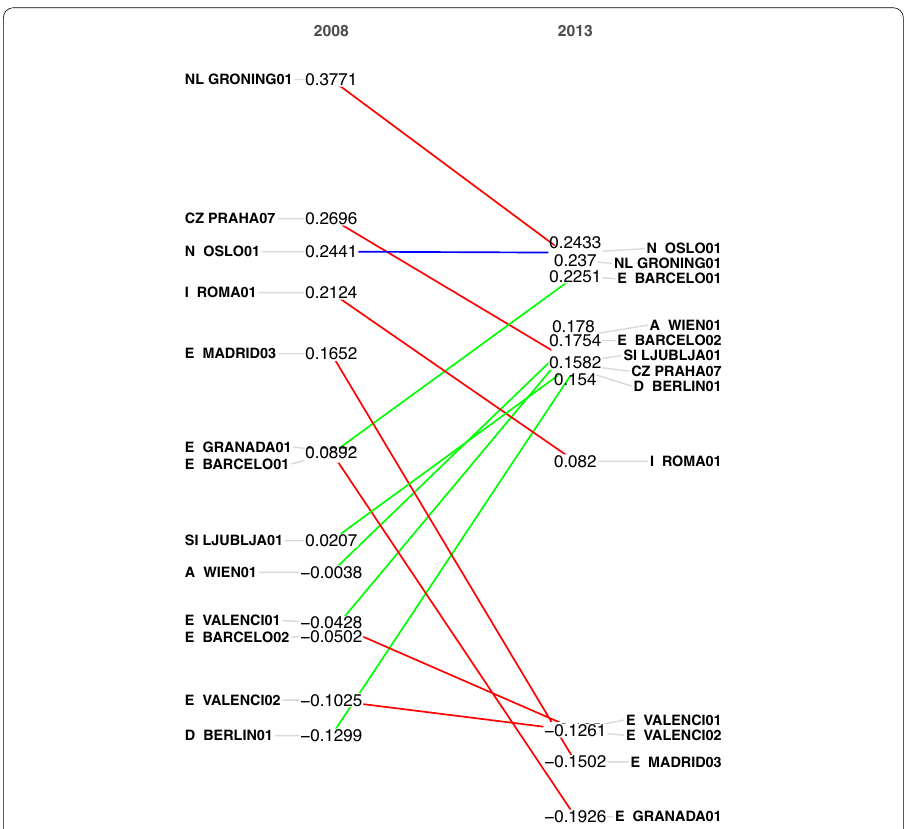
Fig. 5 Average index of inclusiveness at the beginning and at the end of the period 2008–2013. Different line colors indicate different behaviors along time. Red (green) lines highlight a decrease (increase) in the level of inclusiveness; the blue line signals that the level of inclusiveness remained unchanged over